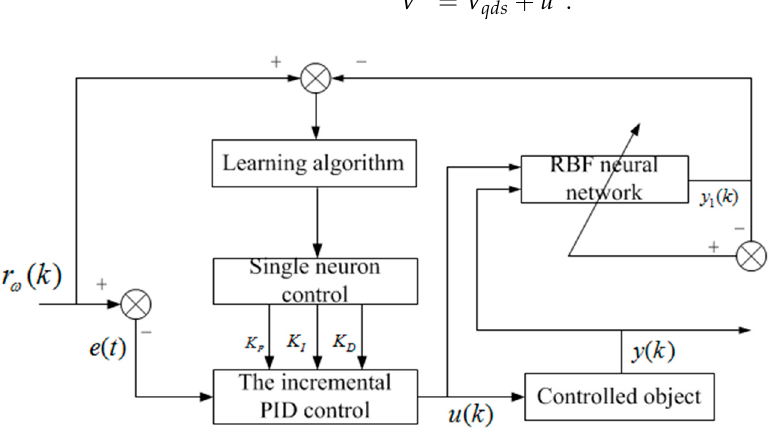
Figure 1. PID control diagram of the RBF neural network.